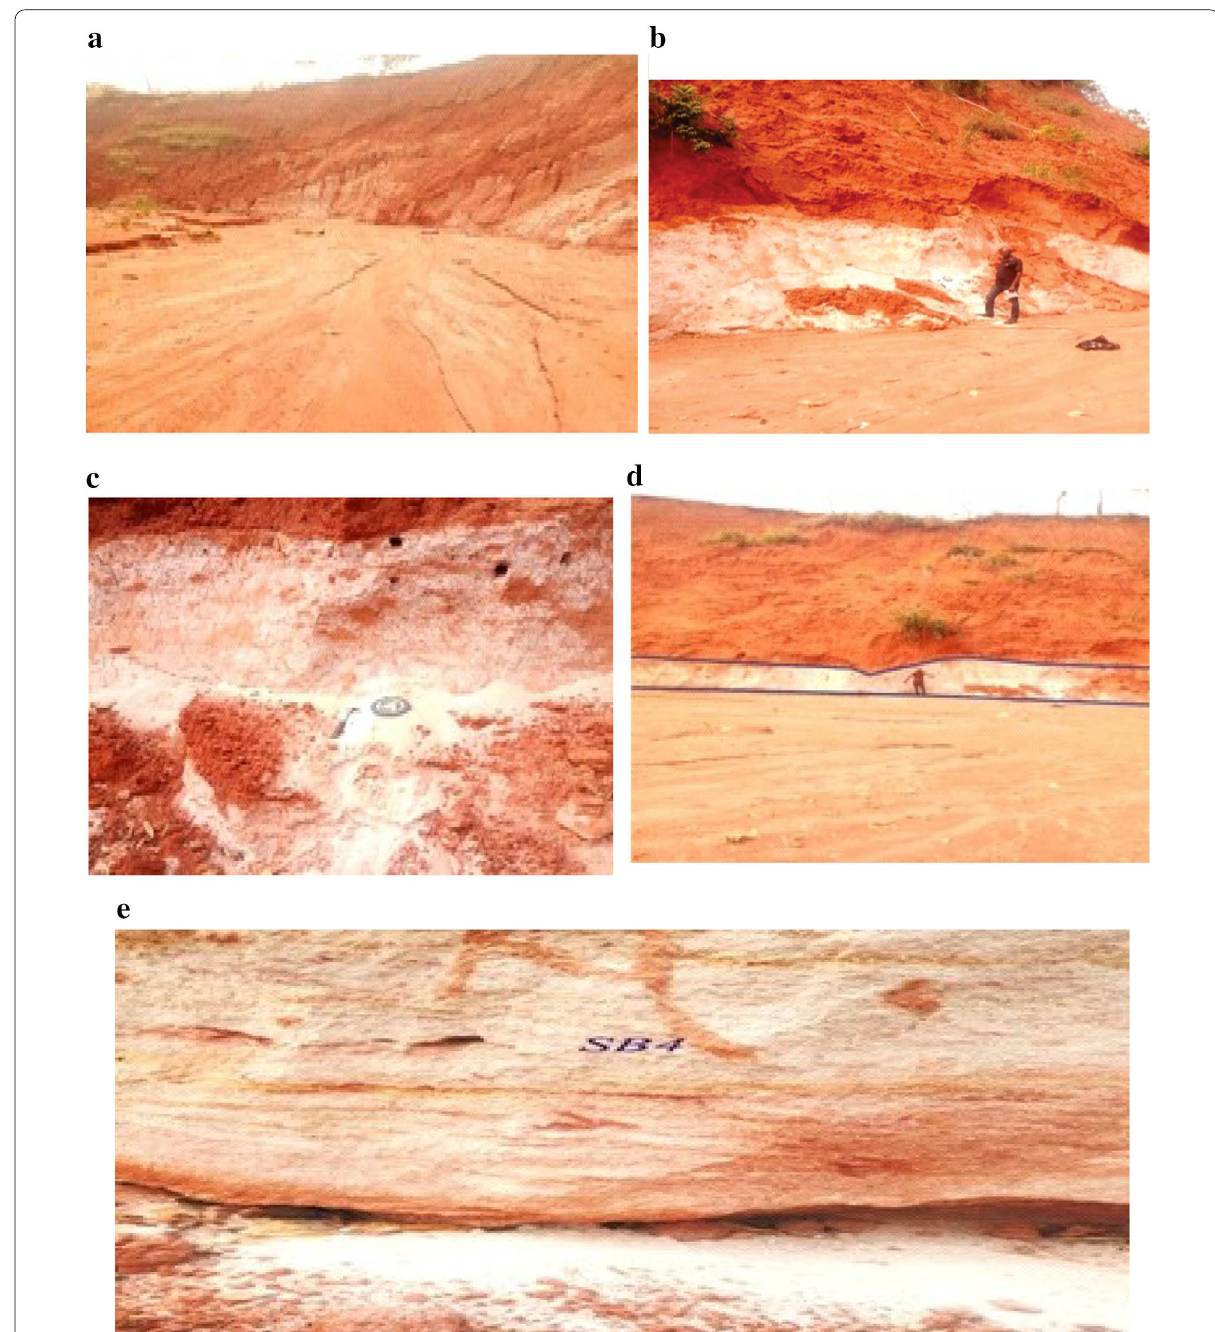
Fig. 6 a Landslide at the study location (photo by Aigbadon). b Lateral soil spread in the study area (photo by Aigbadon). c Soil debris in the study area (photo by Aigbadon). d Ajali Sands with thickness of about 2.5 m marked blue in the study area (photo by Aigbadon). e Ajali sands (SB4) in the study area (photo by